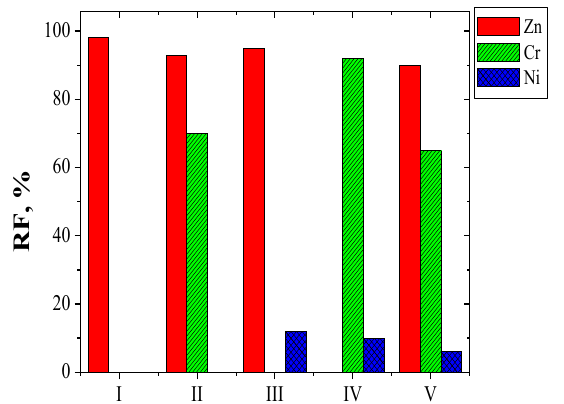
Figure 9. Recovery factor (RF) of zinc, chromium and nickel during transport across PIMs doped with EDAB-acac. Process conditions as in Table 4.